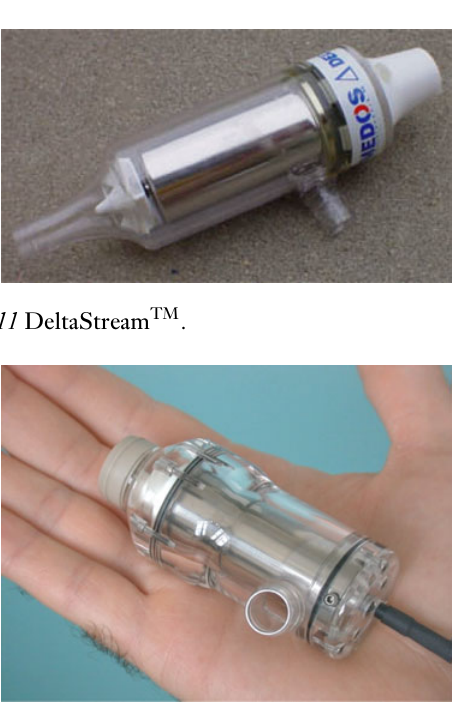
Figure 12 Microdiagonal